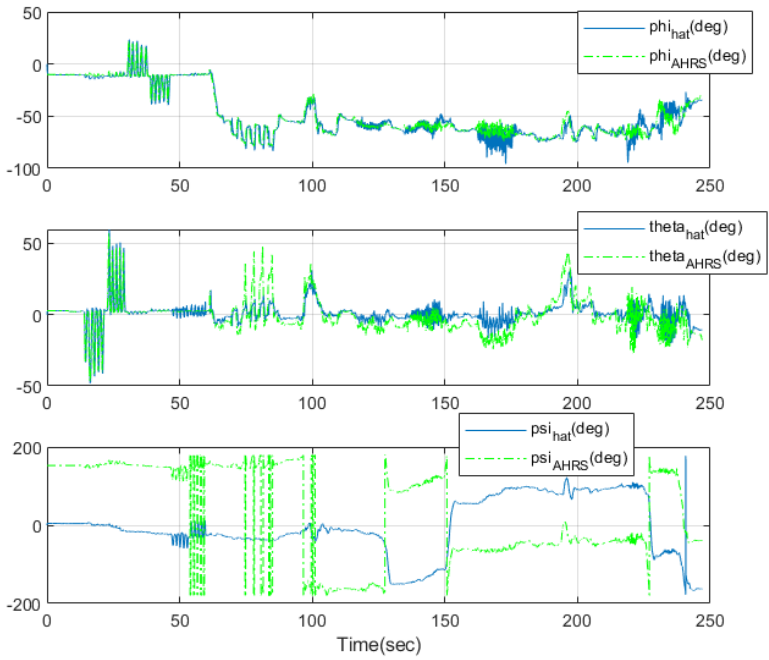
Figure 22. The attitude of the athlete: comparison with Microstraion’s AHRS.